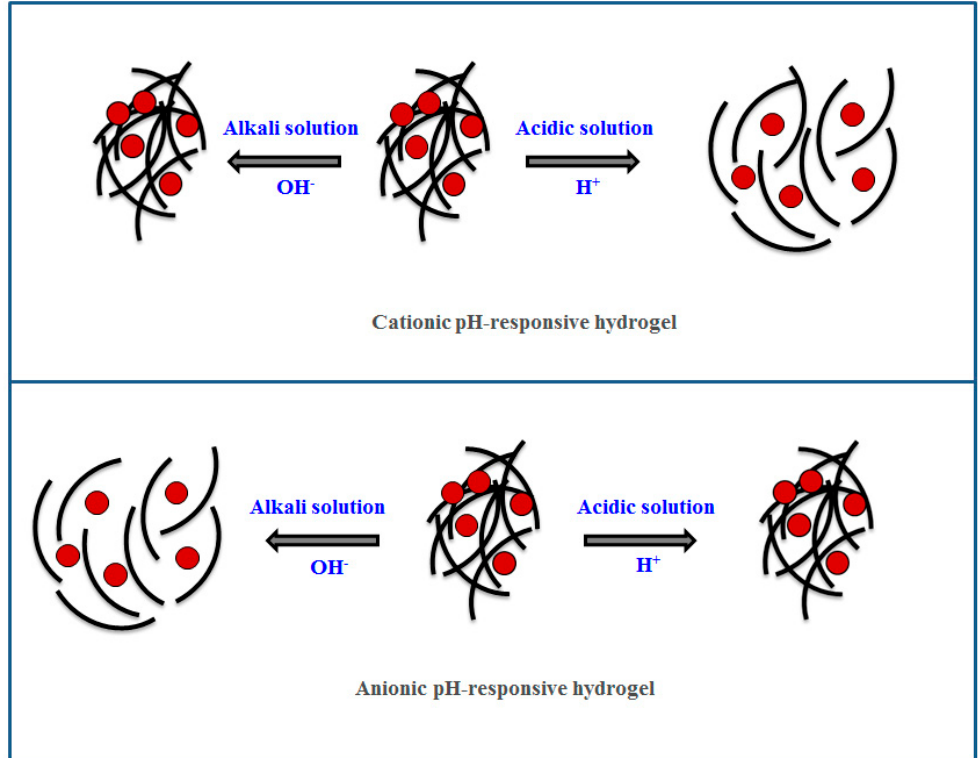
Figure 2. The schematic representation of pH-responsive behavior of the stimuli-responsive polymer hydrogel drug delivery system.